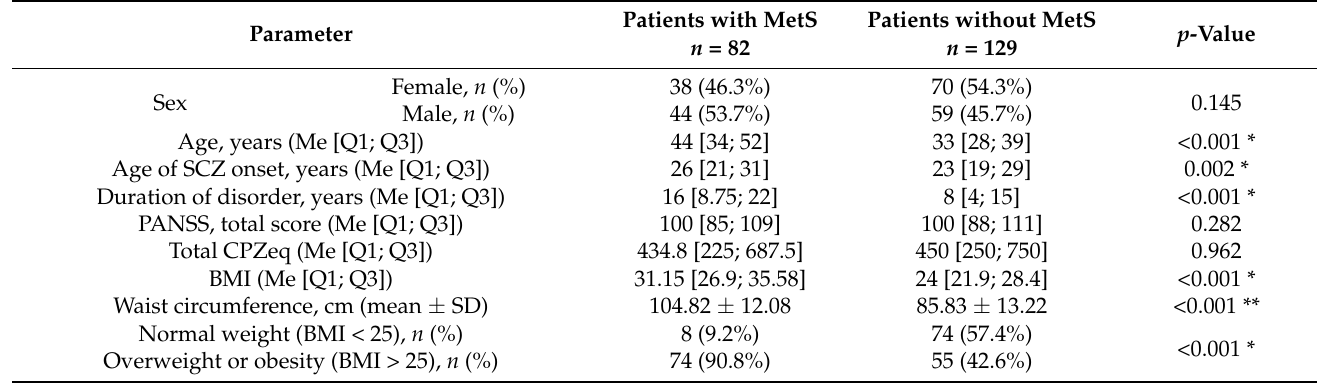
Table 1. The main sociodemographic and clinical characteristics of schizophrenia patients with and without